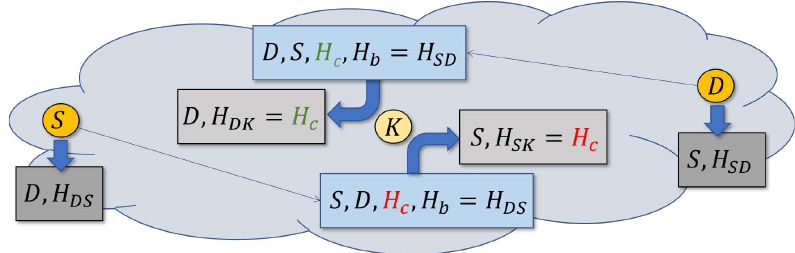
Figure 2. Data for the SPD